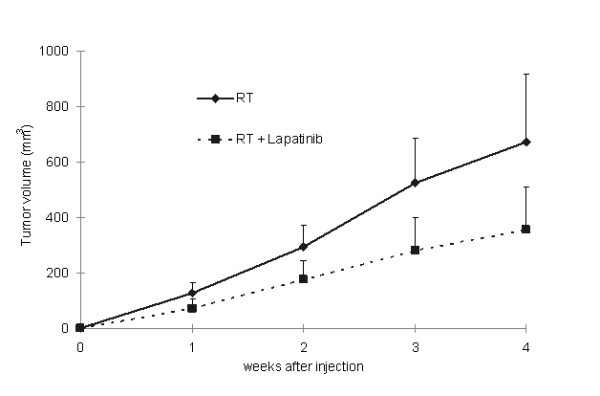
In vivo effect of radiotherapy alone or in combination with lapatinib, in A549 tumor-bearing mice. Lapatinib reduced modestly tumor growth in irradiated animals compared to only irradiated mice.